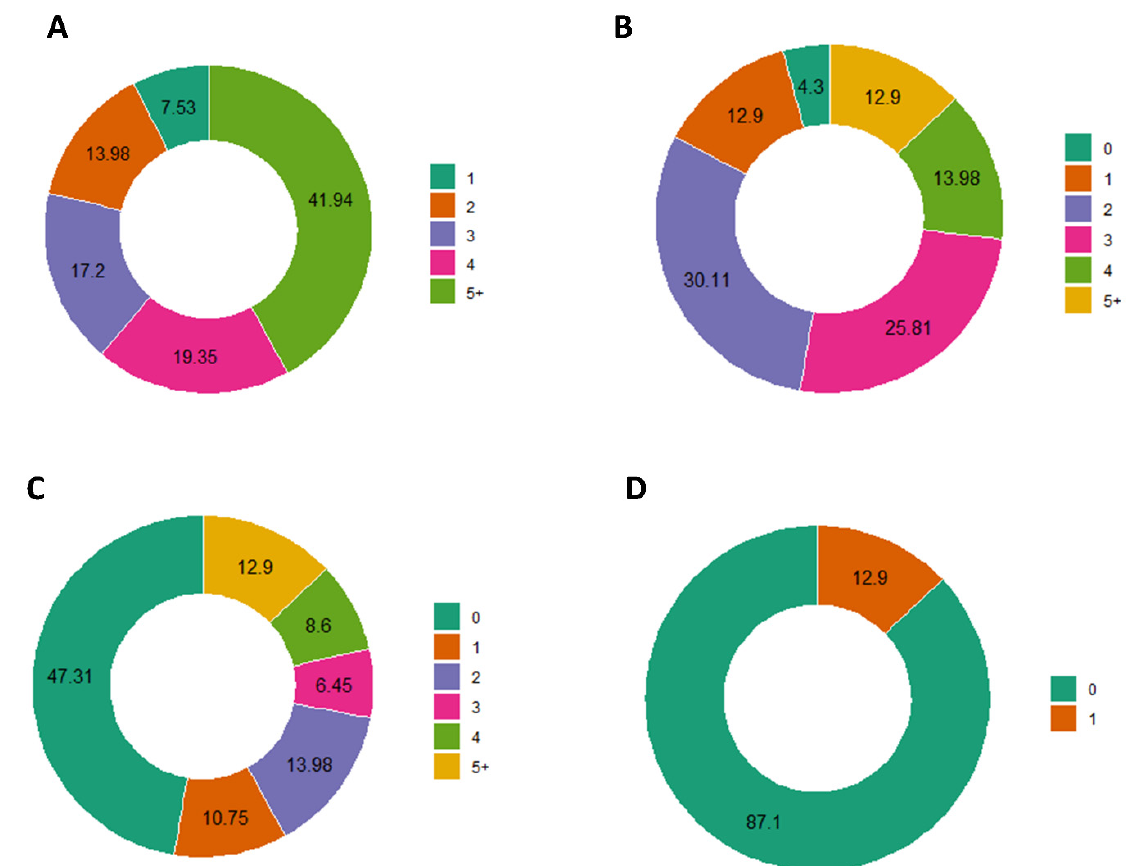
Figure 2. Frequency of patients with: ( A ) one or more concomitant alterations, considering all types of gene alterations, ( B ) one or more gene variants, ( C ) one or more CNA, and ( D ) one or more re-arrangements.